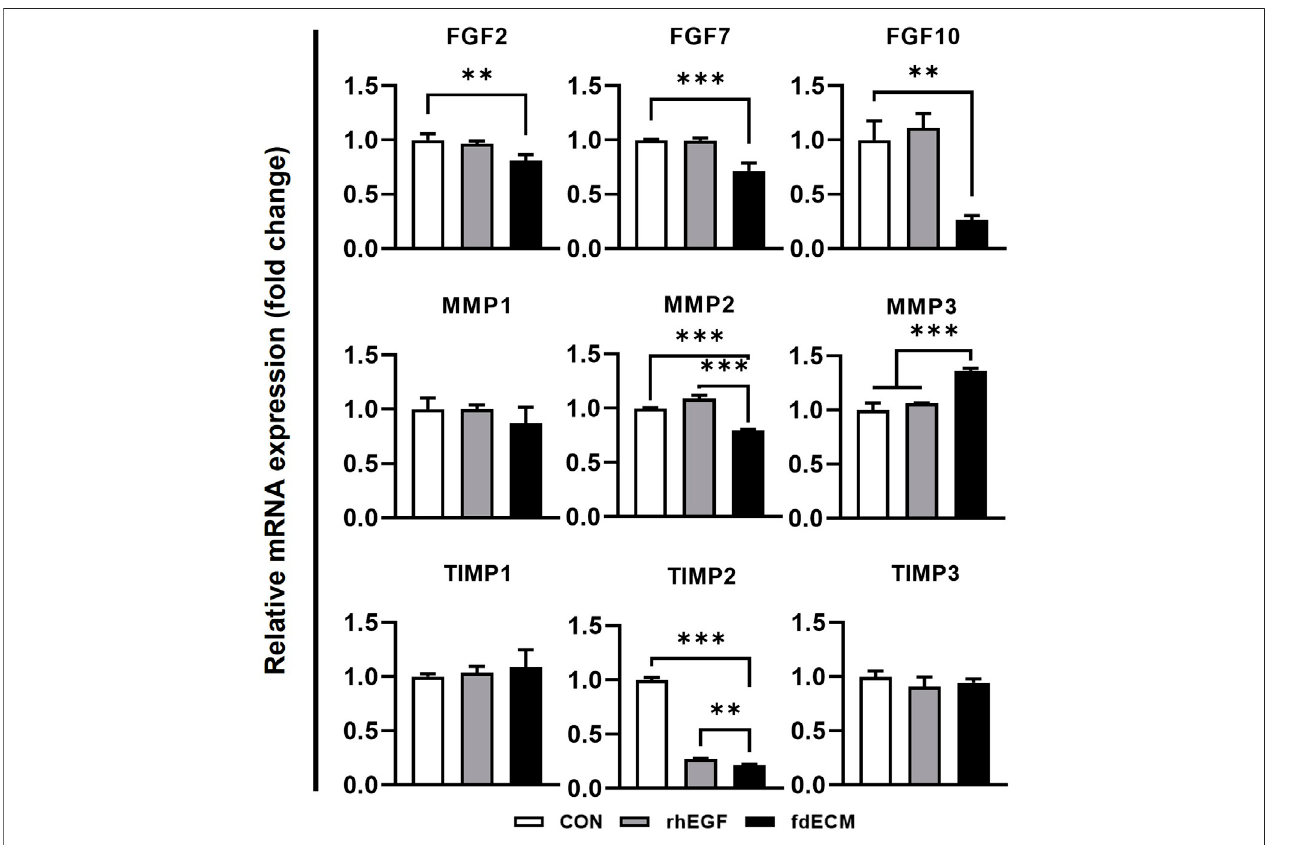
FIGURE 7 | mRNA expression pattern of fi broblasts after 48 h of fdECM treatment. Real-time PCR was used to analyze mRNA expression levels after 48 h of rhEGF or fdECM treatment. Results are expressed as mean ± standard deviation (SD). ** p < 0.01, *** p < 0.001.